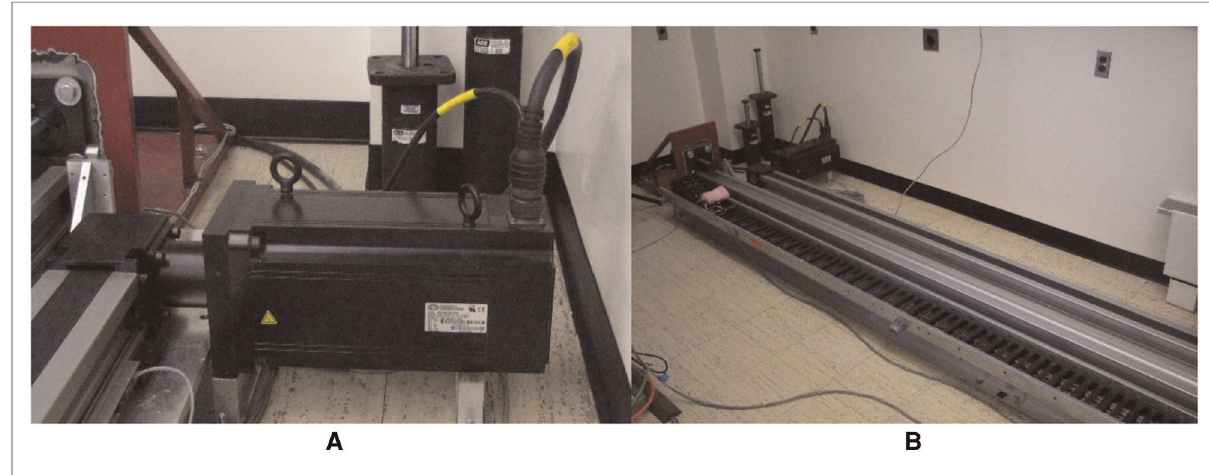
FIGURE 2 Wh120 linear railing system: ( A ) MH8500 servo motor and ( B ) linear